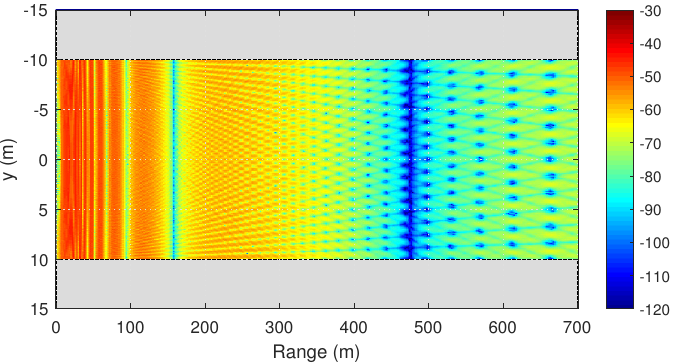
Figure 7. Propagation in a street canyon. Two-dimensional distribution of the signal level (dBm) at the height of 1.5 m, calculated by the two-way PE method.